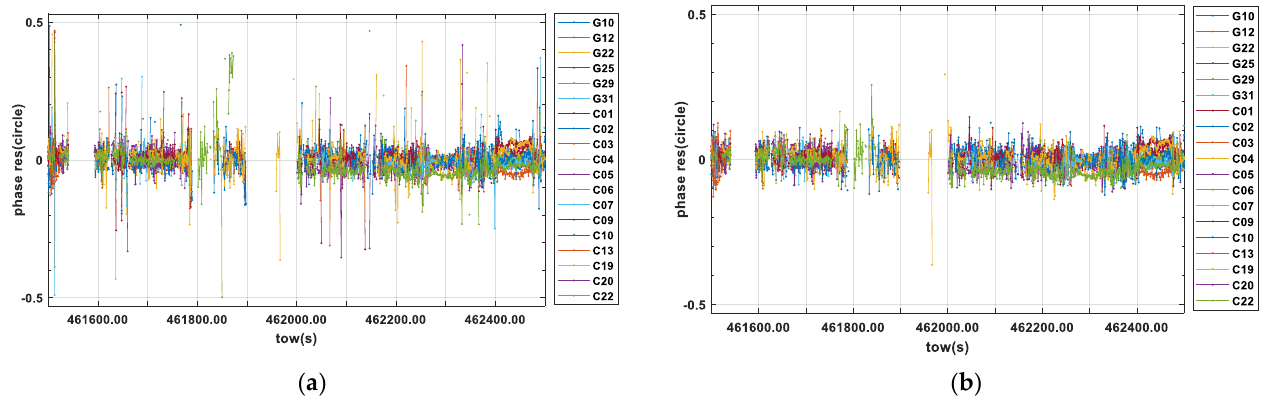
Figure 11. Residuals of the carrier phase: ( a ) residuals of the carrier phase measurements; ( b ) residuals of the retained carrier phase measurements by MAQC method.